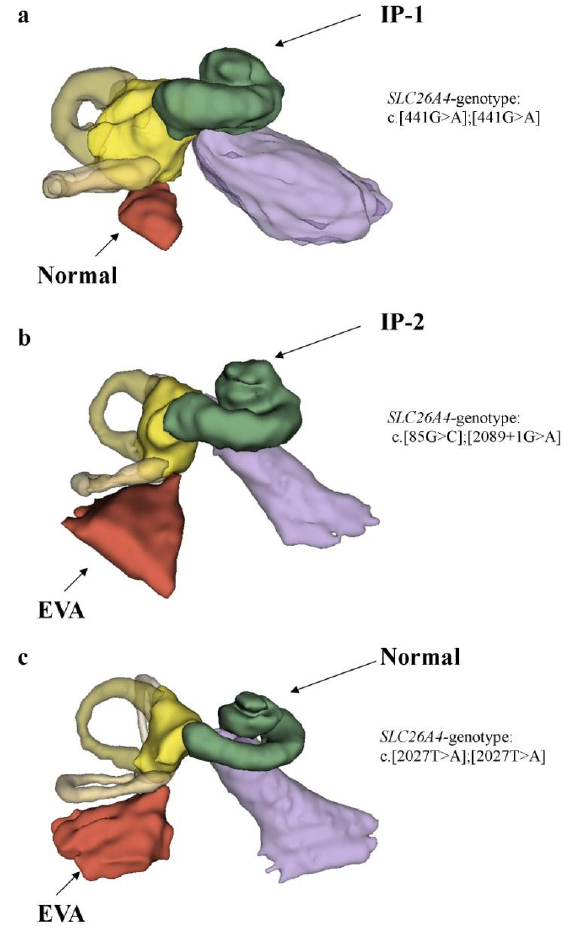
Figure 5. A 3D reconstruction of the incomplete partitions of the cochlea and enlarged vestibular aqueduct anomalies in biallelic SLC26A4 patients. Note. ( a ) Biallelic SLC26A4 patient with an incomplete partition Type 1 (IP-1) cystic cochlear anomaly; ( b ) biallelic SLC26A4 patient with an incomplete partition Type 2 (IP-2) cystic cochlear anomaly combined with EVA; ( c ) biallelic SLC26A4 patient with a normal cochlea and an isolated EVA anomaly.